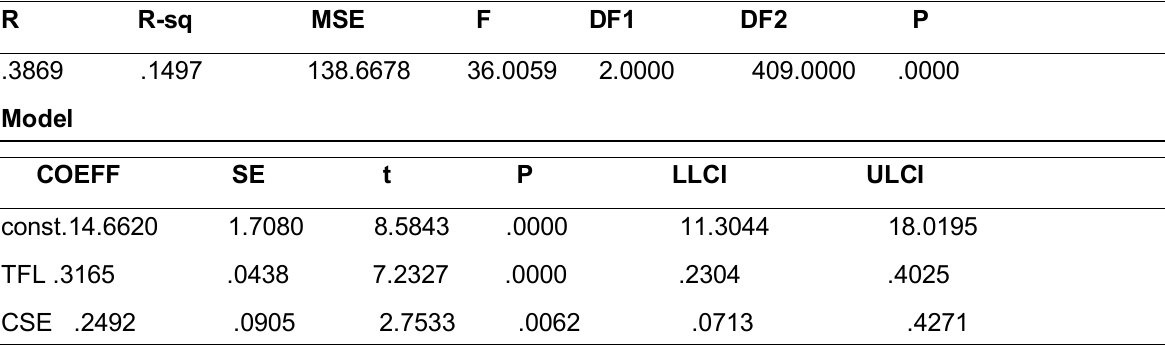
Table 7: Outcome variable / Creative performance behavior